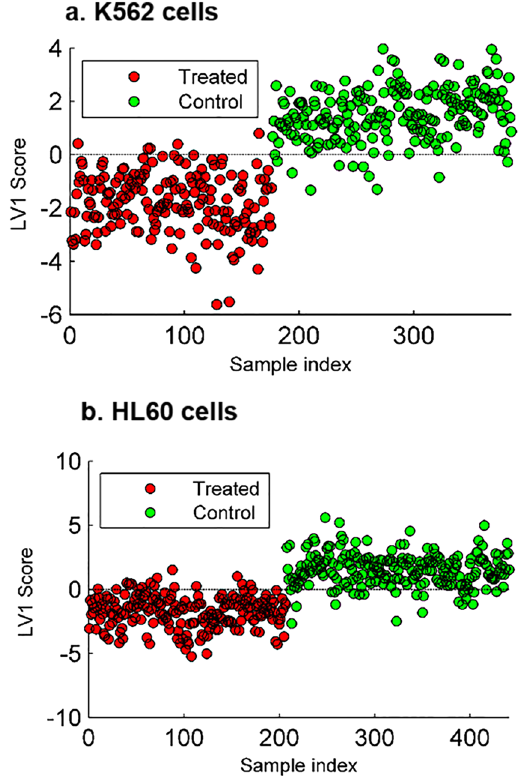
Figure 2. Scores plots for the first oPLS-DA component for S-FTIR spectra of control (green) and BaP treated (red) K562 ( a ) and HL60 ( b ) cells. Each point represents a K562 single cell ( a ) and HL60 single cell ( b